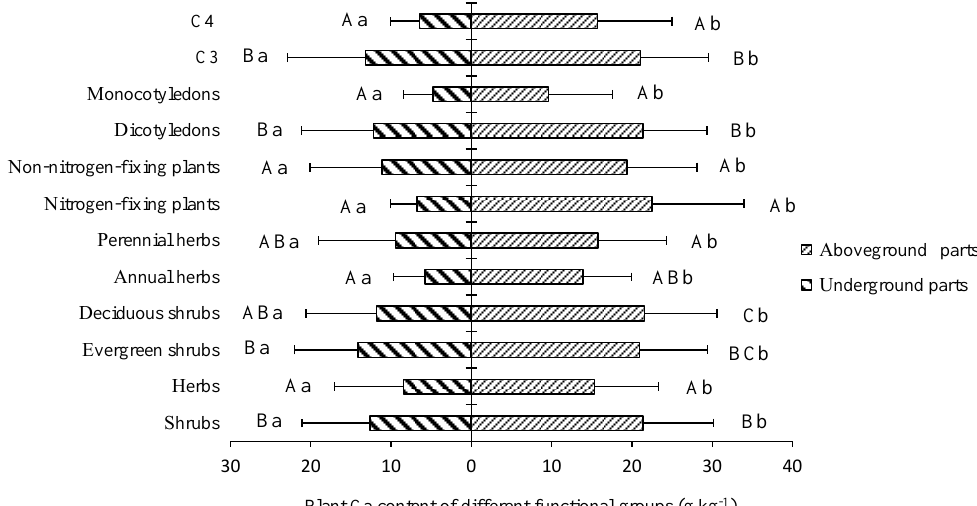
The data represent mean ± standard deviation. Different lowercase letters in each column represent significant differences in different sample points within the same grade of rocky desertification. Different uppercase letters in each row represent significant differences between different grades of rocky desertification ( p <0.05).